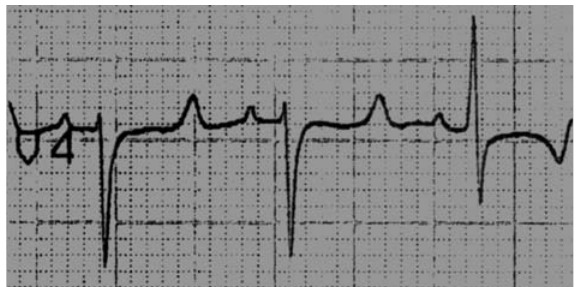
An example of an uncomplicated PVC occurring in the normal ovine heart during the first day of being sub- jected to PVCs. The third beat in this tracing from lead V4 is a PVC. Note the narrow QRS complex with a duration of 40 ms and the isoelectric ST segment. No notching of the QRS complex is